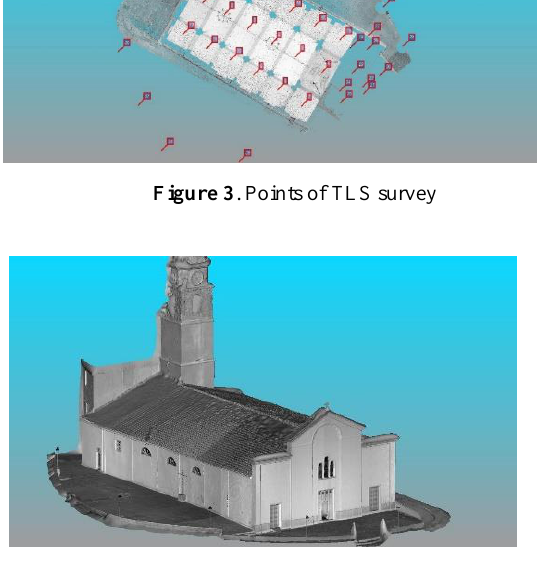
Figure 4 . Church 3D Model